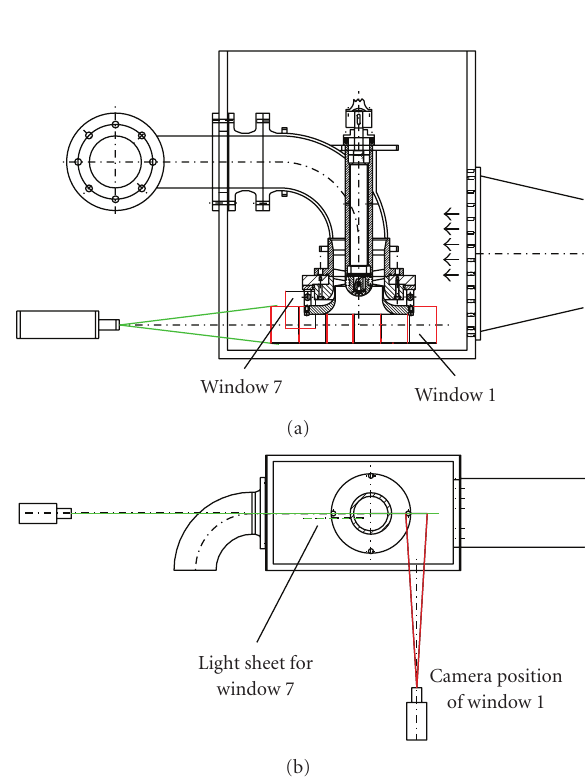
Figure 7: Position of the measuring windows for the examination of the inlet flow of the double-inlet-nozzle (above) and sketch from below (below).